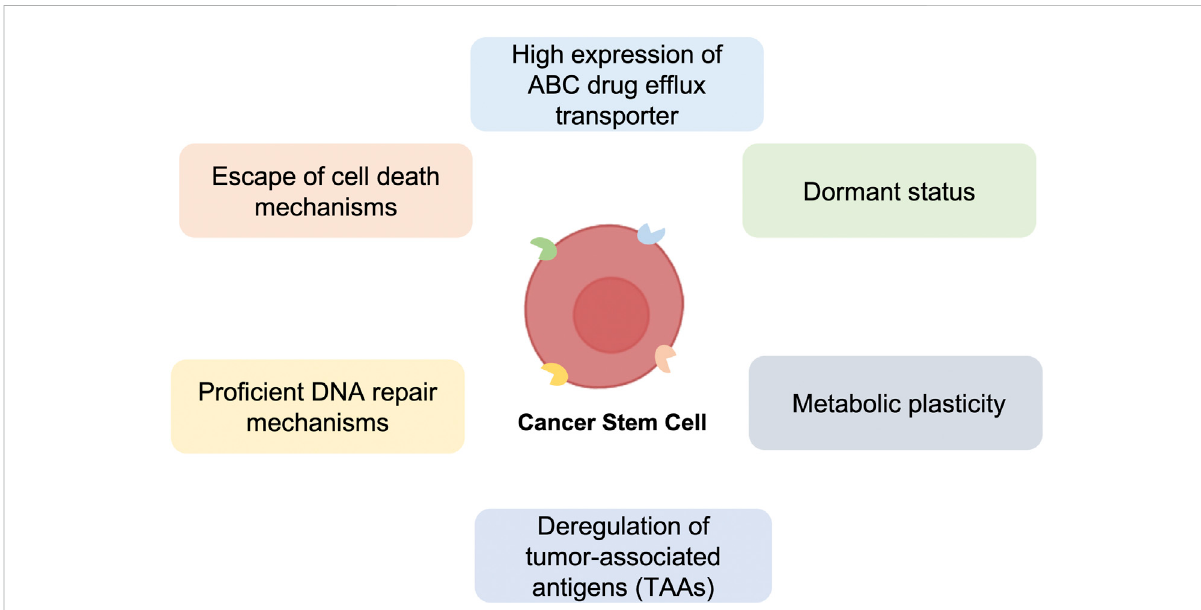
FIGURE 1 Majormechanismsofanti-cancertherapyresistanceofCancerStemCells(CSCs). Schematic representationoftheprincipalCancerStemCells (CSCs) characteristics, including high expression of ABC drug ef fl ux transporter, dormant status, metabolic plasticity, deregulation of tumor- associated antigens (TAAs), pro fi cient DNA repair and escape of cell death mechanisms, which confer resistance to standard anti-cancer